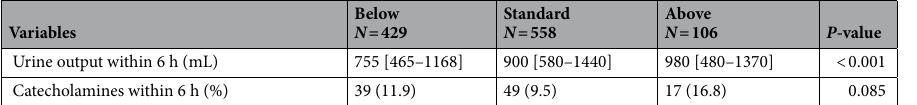
Table 1. Baseline characteristics of the study participants. Continuous variables are expressed as mean (standard deviation) or median [interquartile range]. ACE-I angiotensin-converting enzyme inhibitor, AF atrial fibrillation, ALT alanine aminotransferase, ARB angiotensin II receptor antagonist, AST aspartate aminotransferase, BNP brain natriuretic peptide, BUN blood urea nitrogen, COPD chronic obstructive